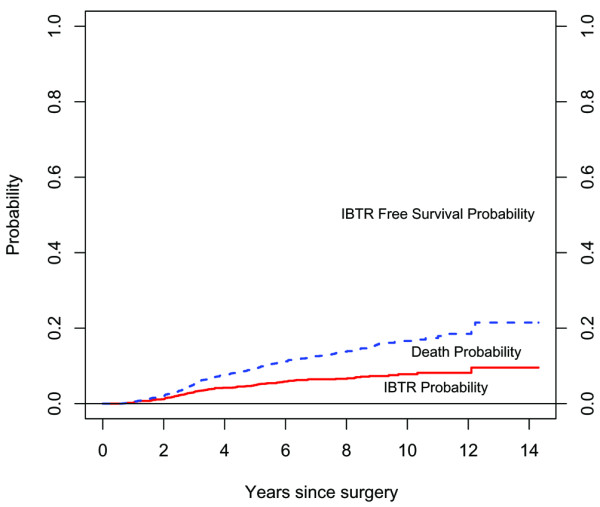
Competing risks between ipsilateral breast tumour recurrence (IBTR) and disease-specific survival.